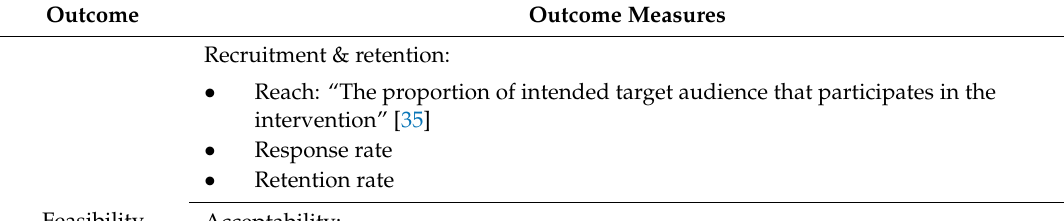
Table 1. Overview outcomes and outcome measures of